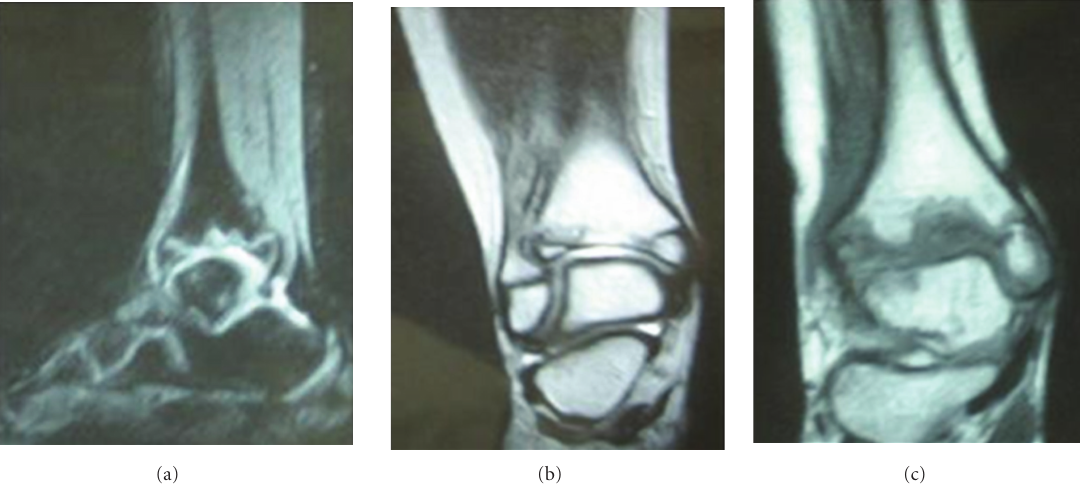
Figure 3: Sagittal T2W (a) and coronal T2W (b) and T1W (c) show total destruction of the epiphyseal centrum with erosion and bone marrow edema of the epiphysis with areas of